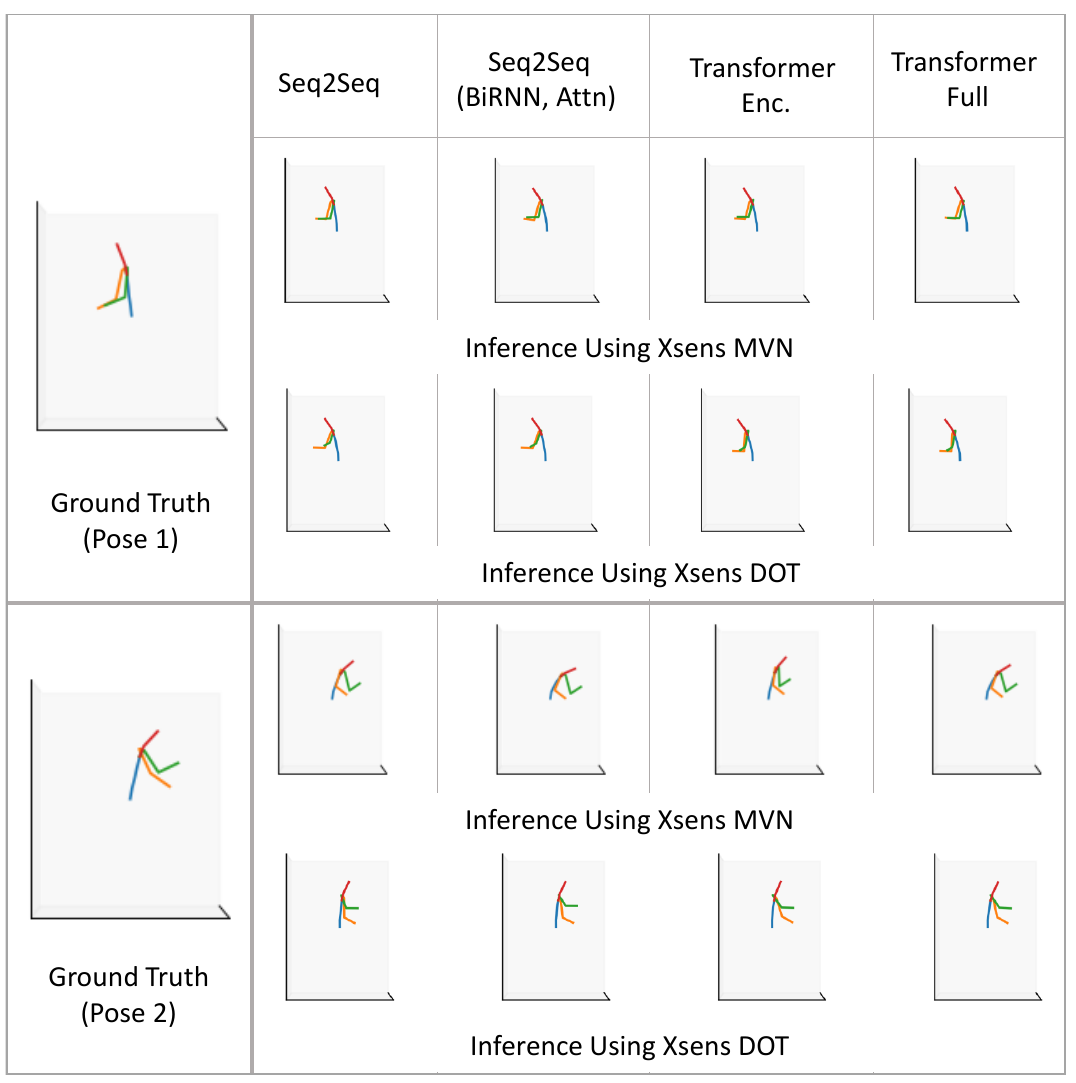
Figure 24. Qualitative evaluation for general human poses while standing (Pose 1) and sitting (Pose